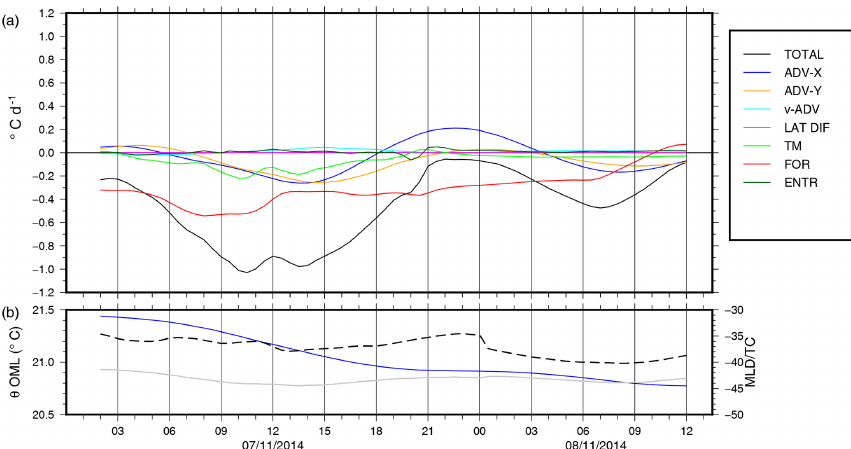
Figure 7. Time series of the different components of the tendency in the evolution of the potential temperature in the OML and in the SFA ( a , colours) and the time evolution of the temperature in the OML (blue), of the MLD (dashed black), and of the T − 10m − 0.3 ◦ C thermocline (grey) in the SFA (b) . The terms represented are horizontal advection (ADV-X and ADV-Y), the vertical advection v-ADV, the lateral diffusion LAT DIFF, the turbulent mixing TM, the surface heat forcing FOR and the entrainment at the bottom of the OML (ENTR).